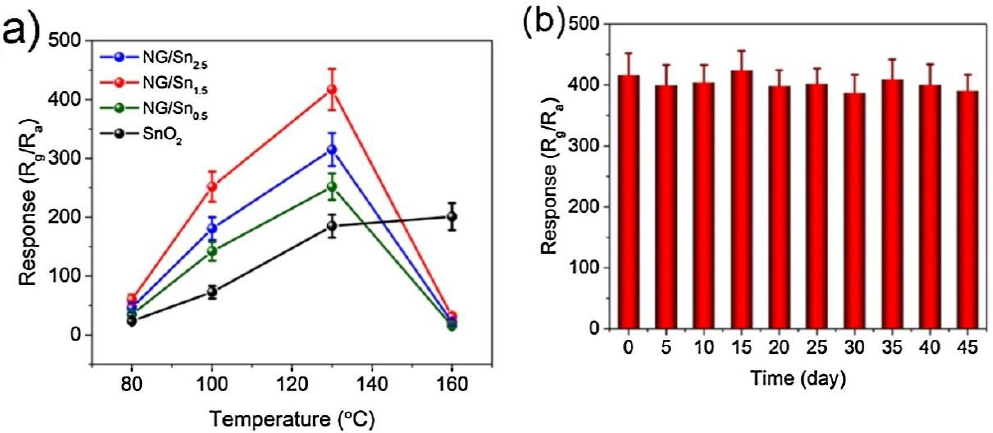
Figure 12. ( a ) Responses of SnO 2 and NGQD/Snx at various temperatures for 1 ppm NO 2 ; ( b ) long- term stability of NGQD/Sn 1.5 sensor to 1 ppm NO 2 in 45 days [105].